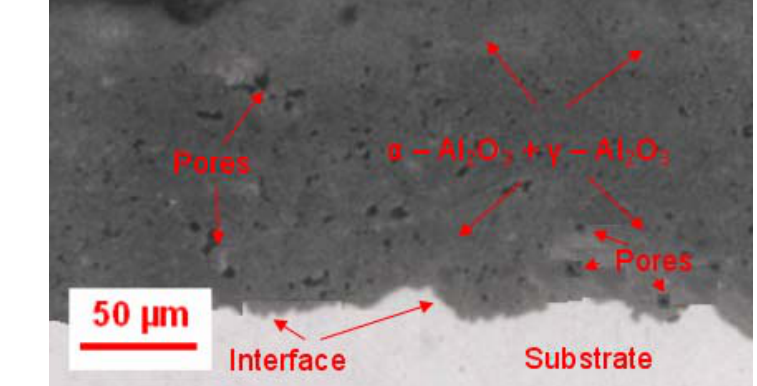
Figure 4 – Cross section and microstructure of the Al 2 O 3 (900A) coatings Рис . 4 – Поперечное сечение и микроструктура Al 2 O 3 покрытия (900A)